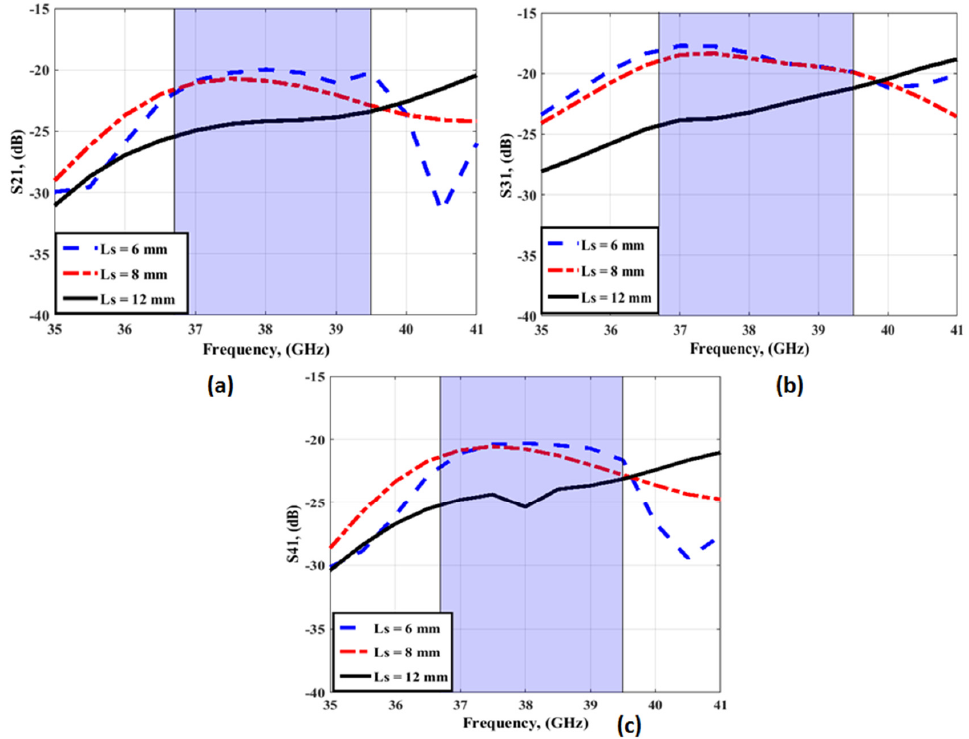
Figure 9. The simulated transmission coefficients with changing Ls ( a ) S 21 ( b ) S 31 ( c ) S 41 .